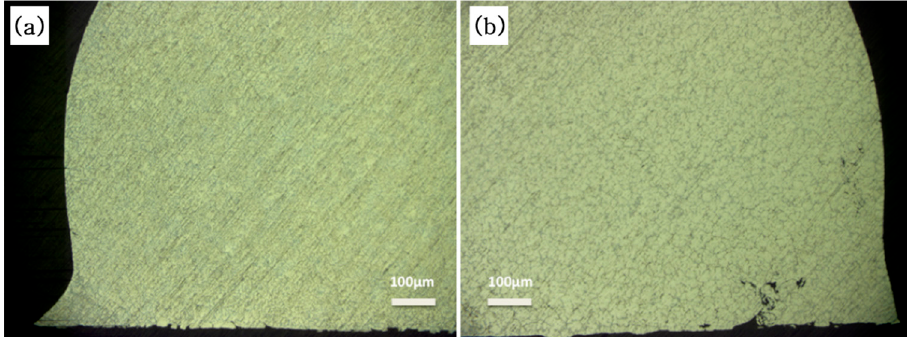
Figure 3. Micrographs of two printed lines presenting a decrease in the contact angle due to re-melting: ( a ) Left side of printed line; ( b ) Right side of printed line (Eclipse LV15ONL and KEYENCE VHX-900 Digital Microscope).